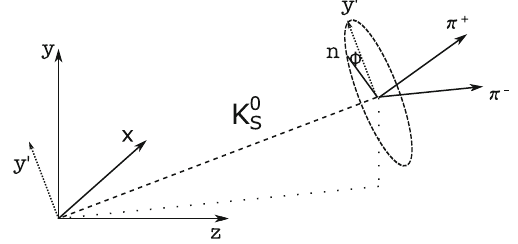
Fig. 3 Definition of angle (cid:4) used for V 0 selection. (cid:4) is defined as the anglebetweenthevectorsy’,andn,wherey’isthevectorperpendicular to the momentum of the V 0 -particle which lies in the plane spanned by the y -axis and the V 0 -momentum vector, and n is a vector normal to the decay